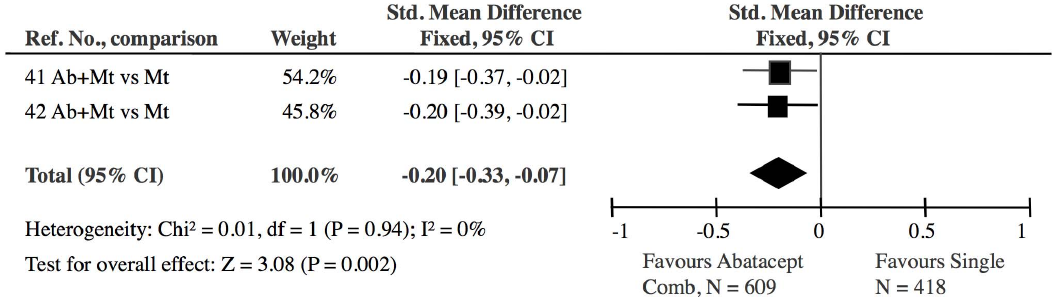
Figure 7. Abatacept combined with methotrexate versus single DMARD (methotrexate): The effect of abatacept was significant (Z=3.08). The 2 abatacept studies showed no heterogeneity (I 2